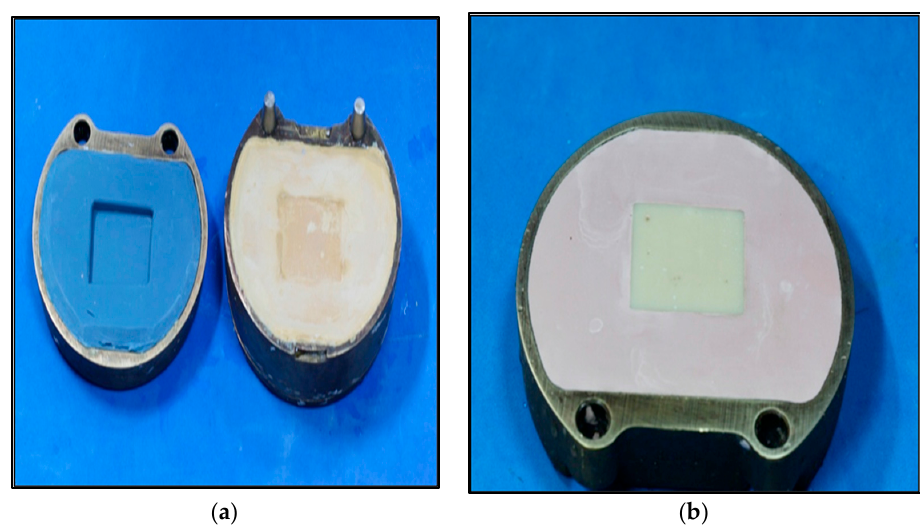
Figure 2. ( a ) Customized standard mold. ( b ) Fabricated resin material of 40 × 45 × 15 mm block.